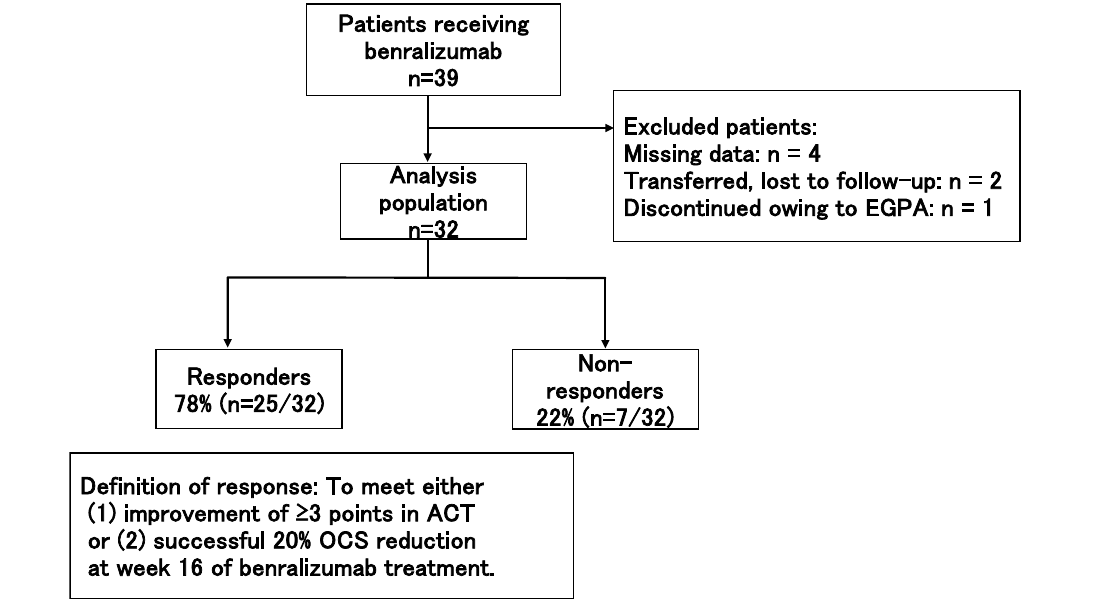
Figure 1 Evaluation at week 16 of benralizumab treatment and baseline characteristics EGPA, eosinophilic granulomatosis with polyangiitis; OCS,